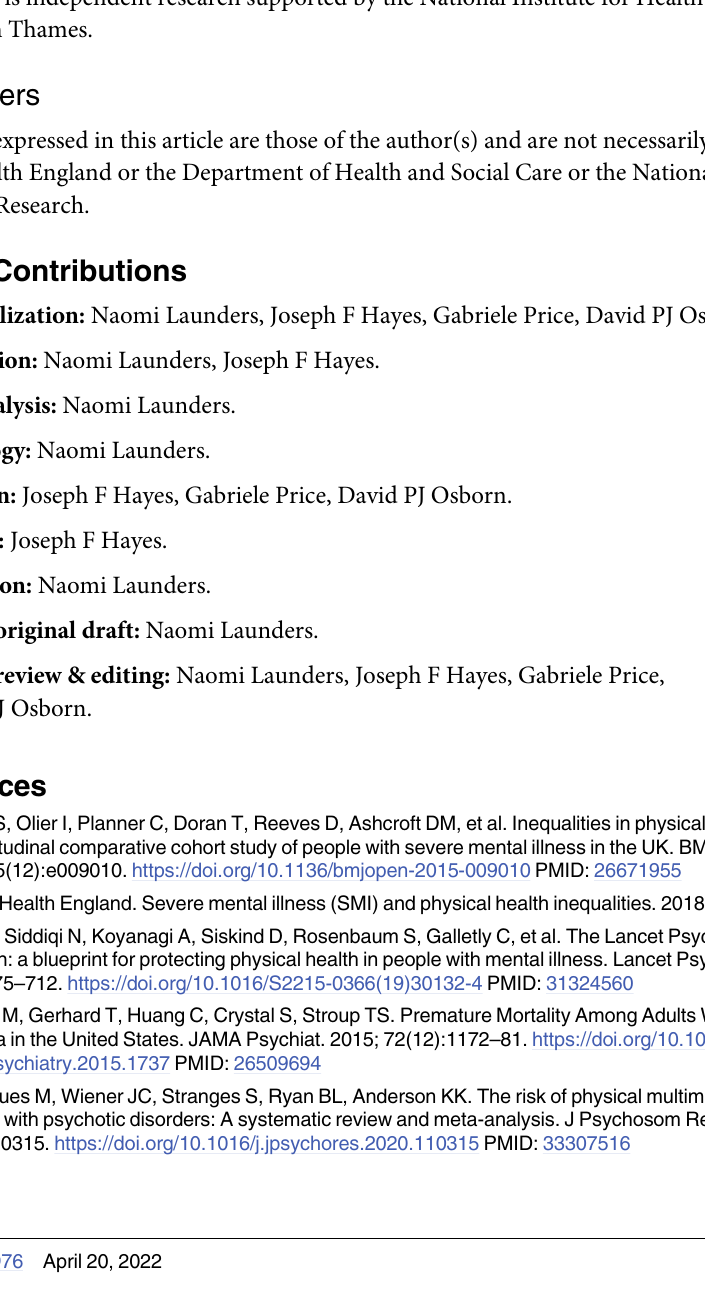
S1 Fig. Pattern of variables in MCA in SMI and comparator cohorts. MCA, multiple corre- spondence analysis; SMI, severe mental illness. S1 Table. ORs of physical health conditions in patients with missing ethnicity, compared to white ethnicity. OR, odds ratio. S2 Table. aORs of physical health conditions after multiple imputation for missing ethnic- ity. aOR, adjusted odds